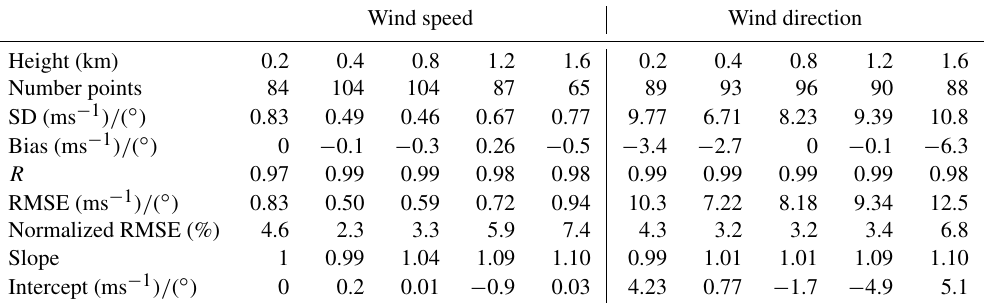
Table 5. Statistics of the comparison between CDL and radiosonde at heights of 0.2, 0.4, 0.8, 1.2, and 1.6km. Normalized RMSE is defined as RMSE divided by the maximum range of the measured values